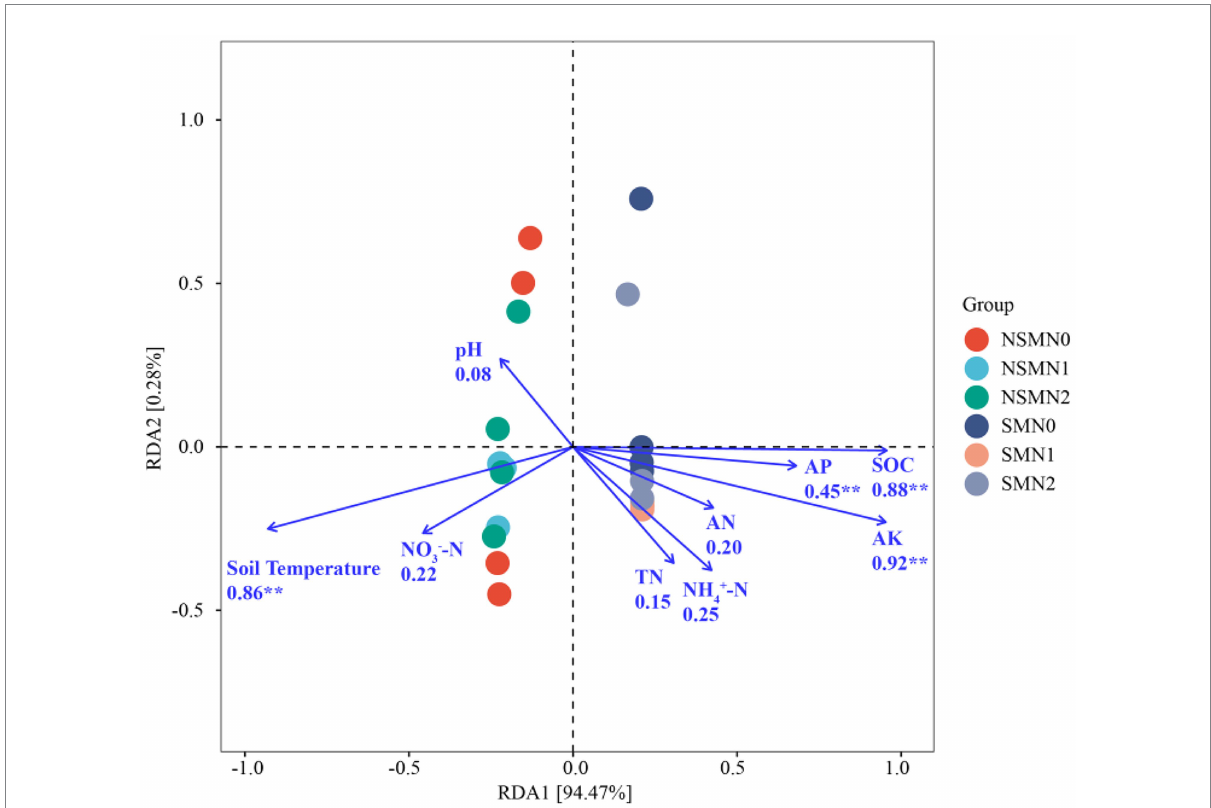
FIGURE 7 The relationships between environmental factors and bacterial communities in wheat rhizosphere soil under straw mulching and N fertilization treatments. NSM, no straw mulching; SM, straw mulching; N0, no N; N1, 120 kg N ha − 1 ; N2, 180 kg N ha − 1 . SOC, Soil organic C; TN, Total N; AN,